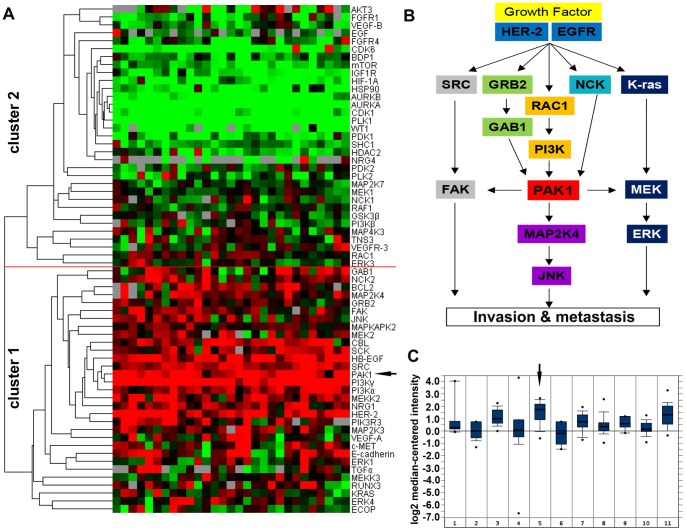
Bioinformatics analysis of PAK1 in GEJ adenocarcinoma.(A) Hierarchical clustering of mRNA expression profiles in the candidate gene set, which comes from the targeted therapy-related signaling of gastric or esophageal tumors [7], [9], based on their similarity to each other in a cohort of 27 GEJ adenocarcinoma cases. Two main clusters were clearly distinguished; overall, expression of genes in cluster 1 was higher than those in cluster 2. HER-2, NRG1, SRC, PI3Ks, PAK1 (arrow), MEKK2 and SCK exhibit prevalently higher mRNA levels than the others. Cluster 1 mainly consists of genes related to HER-2 and EGFR pathways, while cluster 2 consists of genes involving other pathways such as VEGFR and aurora kinase signaling. (B) Putative PAK1-related signaling pathways (modified from KEGG). Cluster color key: red = relative upregulated; green = relative downregulated; black = relative unchanged; grey = missing. (C) A cancer-spectrum analysis of PAK1 expression on ONCOMINE dataset indicated that GEJ adenocarcinoma (arrow) exhibits almost the highest PAK1 mRNA level in all 11 types of cancers. Abbreviations: 1. bladder cancer (n = 8); 2. clear cell renal cell carcinoma (n = 11); 3. colorectal adenocarcinoma (n = 23); 4. ductal breast carcinoma (n = 26); 5. gastroesophageal adenocarcinoma (n = 12); 6. hepatocellular carcinoma (n = 7); 7. lung adenocarcinoma (n = 14); 8. ovarian serous surface papillary Carcinoma (n = 27); 9. pancreatic adenocarcinoma (n = 6); 10. prostate adenocarcinoma (n = 26); 11. squamous cell lung carcinoma (n = 14).